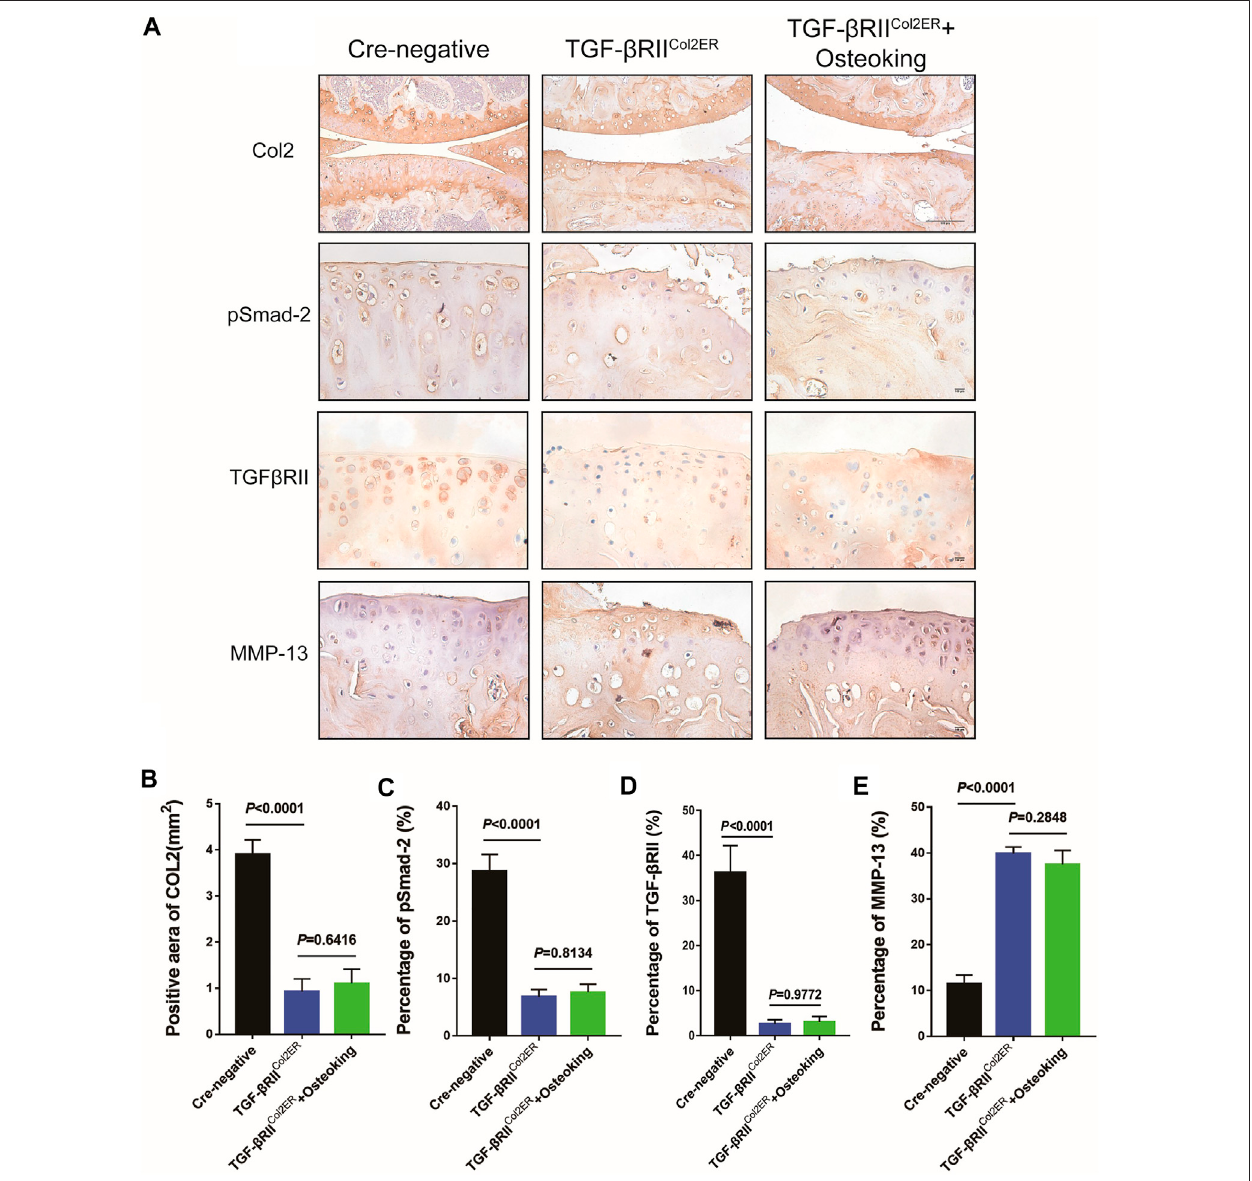
FIGURE 6 | The expression of MMP-13 was not down-regulated after the treatment of Osteoking in TGF β RII Col2ER mice. (A) Immunohistochemistry staining for Col2,pSmad2,TGF β RII,andMMP-13incartilage.Scalebar (cid:2) 100 μ m. (B – E) Quanti fi cationofthepositiverepression ofthese markers.Dataarepresented asmeans ± SD (n (cid:2) 10). The exact p value is presented in the corresponding